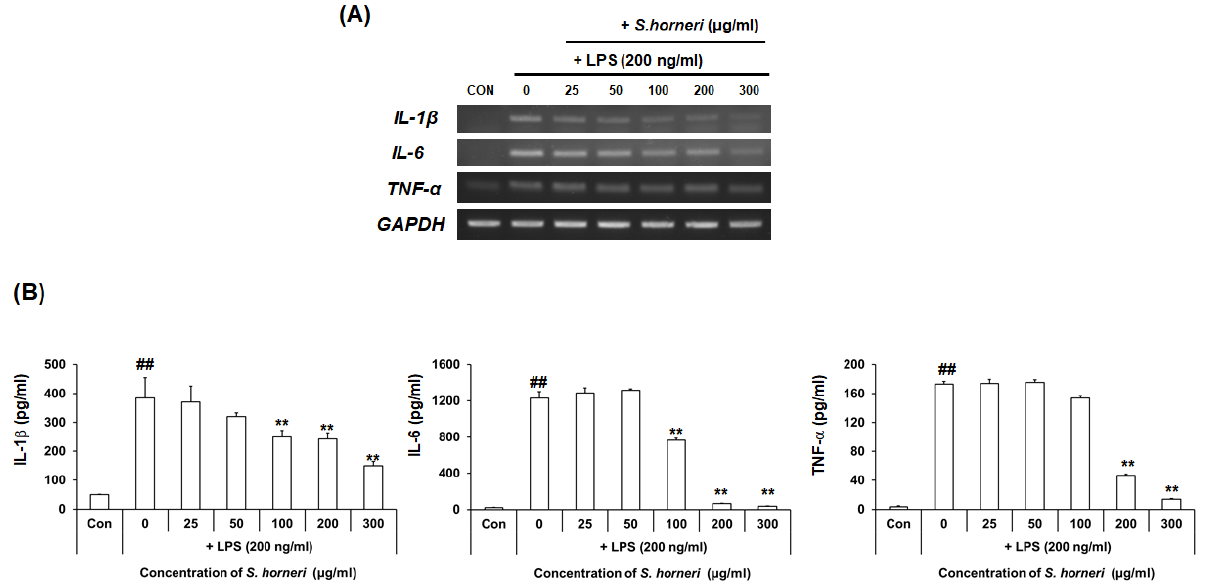
Figure 3. Effect of S. horneri extract on the production levels of IL-1β, IL-6 and TNF-α in LPS-stimulated BV-2 microglial cells. S. horneri extract was pretreated with BV-2 microglial cells 2 h and then incubated with 200 ng/mL LPS for 6 h. RNA was isolated and analyzed by RT-PCR. IL-1β, TNF- α and IL-6 gene expression was confirmed, respectively ( A ). The cells were pre-treated with S. horneri extract (25, 50, 100, 200 and 300 µg/mL) for 2 h, followed by treatment of LPS (200 ng/mL) for 24 h; the levels in the supernatants were measured by ELISA ( B ). Each bar indicates the mean ± SE of four independent experiments. ** p < 0.001, significantly different from LPS-treated group; ## p < 0.001, significantly different from LPS-untreated group.